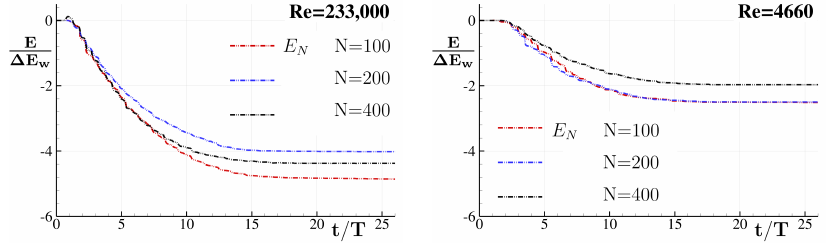
Figure 10. Energy dissipation due to numerical viscosity for different spatial resolutions. ( Left ) 2D water test-case. ( Right ) 2D oil